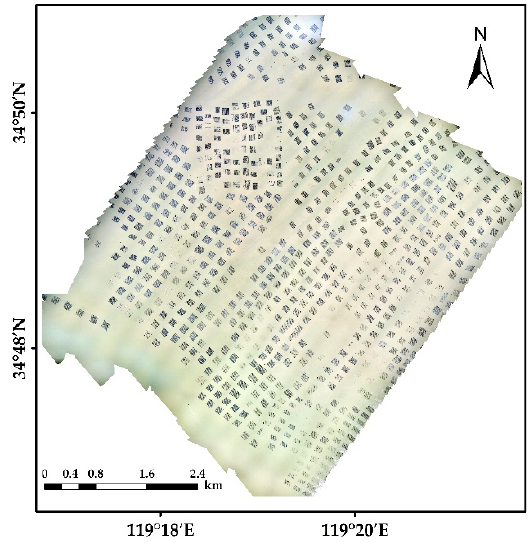
Figure 1. Remote sensing image for the experiment .